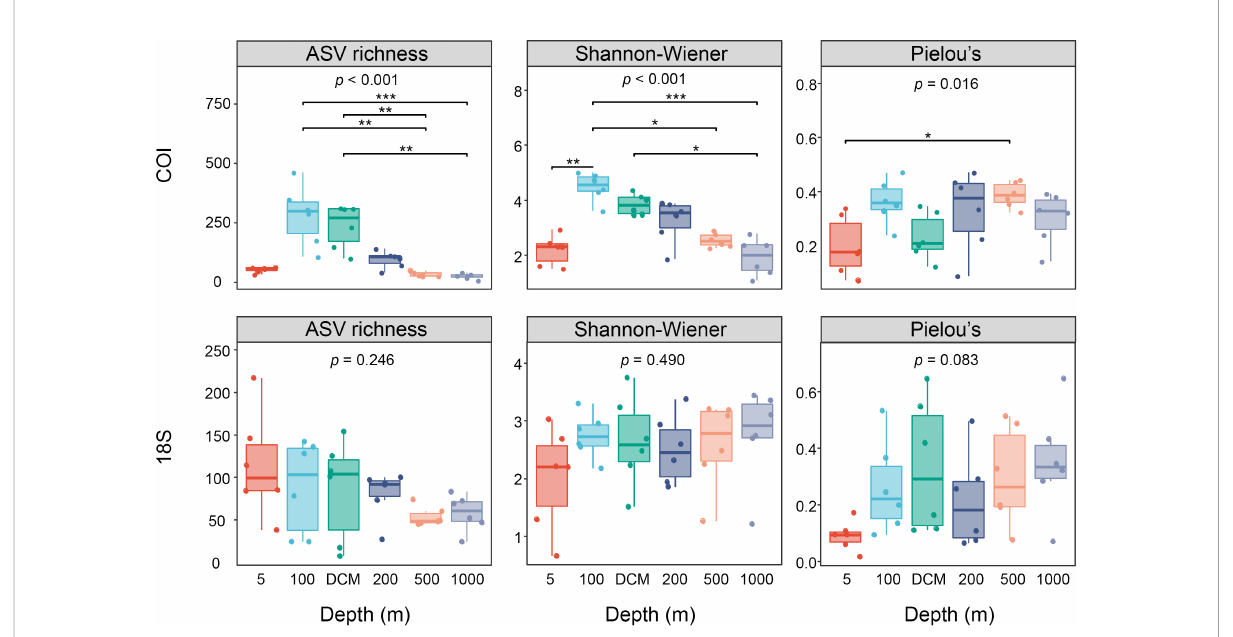
FIGURE 5 Boxplots of ASV richness, Shannon – Wiener diversity index, and Pielou ’ s evenness index of six depth groups identi fi ed by COI and 18S. Kruskal- Wallis tests were conducted among six depth groups. * represents p <0.05; ** represents p <0.01; *** represents p